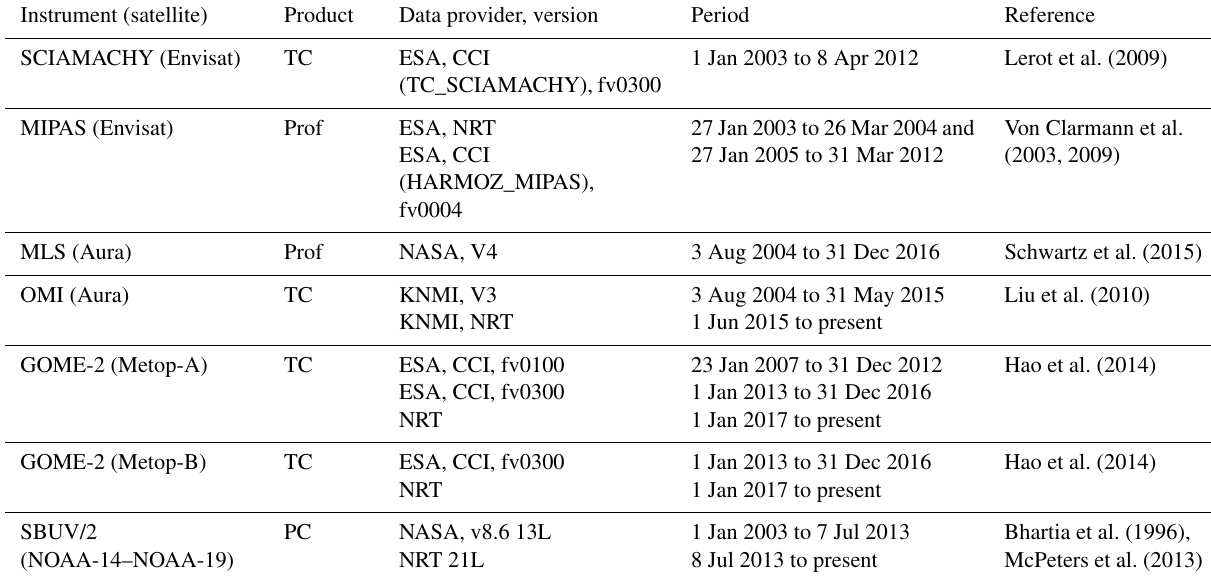
Table 3. Observations of ozone used in the CAMS-Rean assimilation